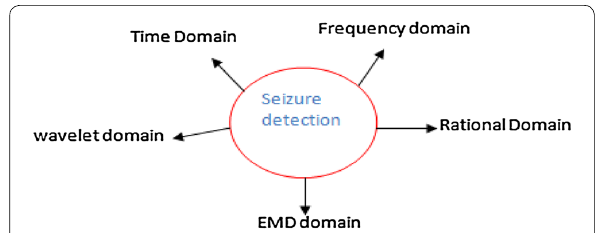
Fig. 1 Classification of seizure detection